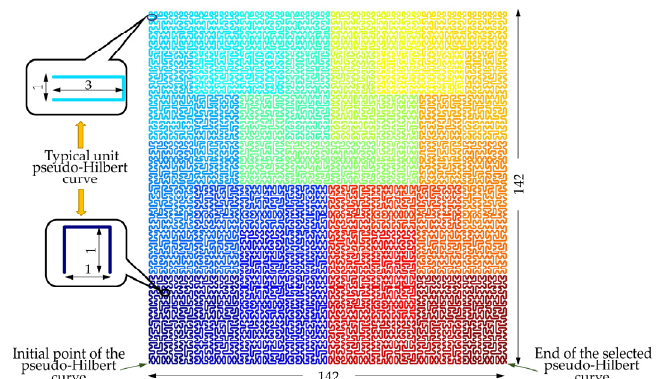
Figure 5. The pseudo-Hilbert curve for encoding the one-dimensional vibration